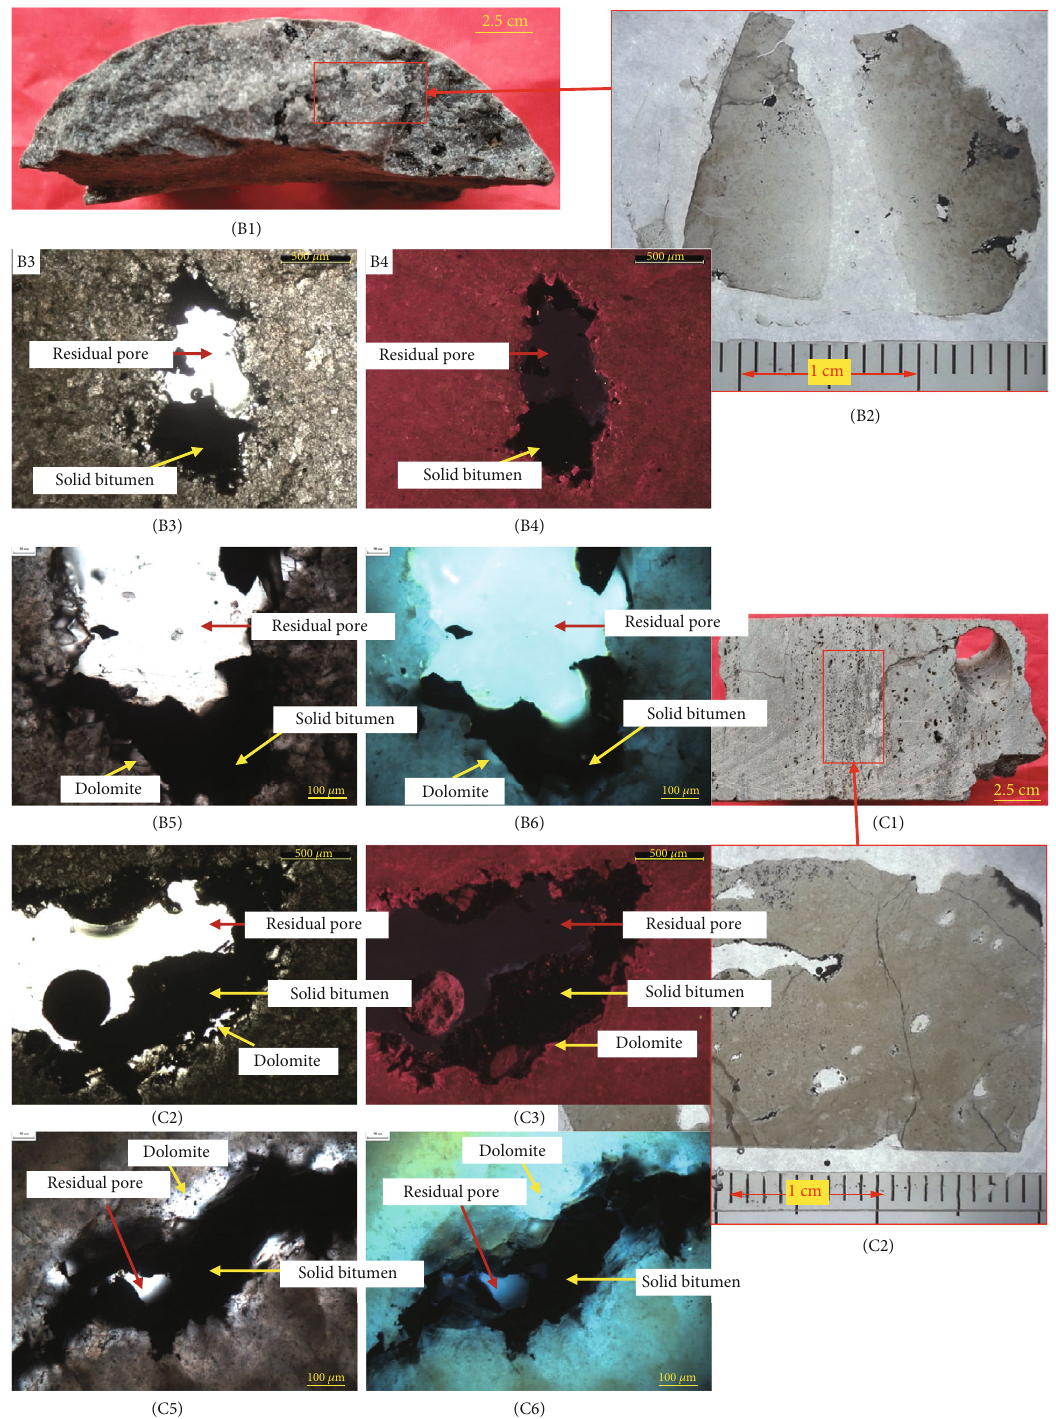
Figure 3: The Longwangmiao Formation in Well MX22 (4941.83-4943.88 m). Photos of cores and thin sections with accompanying petrological observations. (B1) 4941.83m, the core petrology is powdery crystal dolomite with dissolution pores and cavities. (B2) Thin- section scans show asphalt partially fi lling intercrystalline pores and dissolution pores. (B3) (-) and (B4) (CL) Dissolution pore partially in fi lled with asphalt and residual pores. (B5) (-) and (B6) (UV) Dissolution pore fi ll suite: a small amount of dolomite → solid asphalt → residual pores. (A5) (-) and (C1) 4943.72-4943.88m, the core petrology is a fi ne-grained powder crystal dolomite with bedding parallel dissolution pores. (C2) Observation of thin sections shows rims of asphalt fi ling dissolution holes. (C3) (-) and (C4) (CL) Dissolution pore fi ll suite: a small amount of dolomite → solid asphalt → residual pores. (C5) (-) and (C6) (UV) Pore fi ll types identi fi ed in intercrystalline pores in powder crystal dolomite dissolution pores included the following: dolomite → solid asphalt → residual pores. (-): plane polarized light; CL: cathodoluminescence; UV: fl